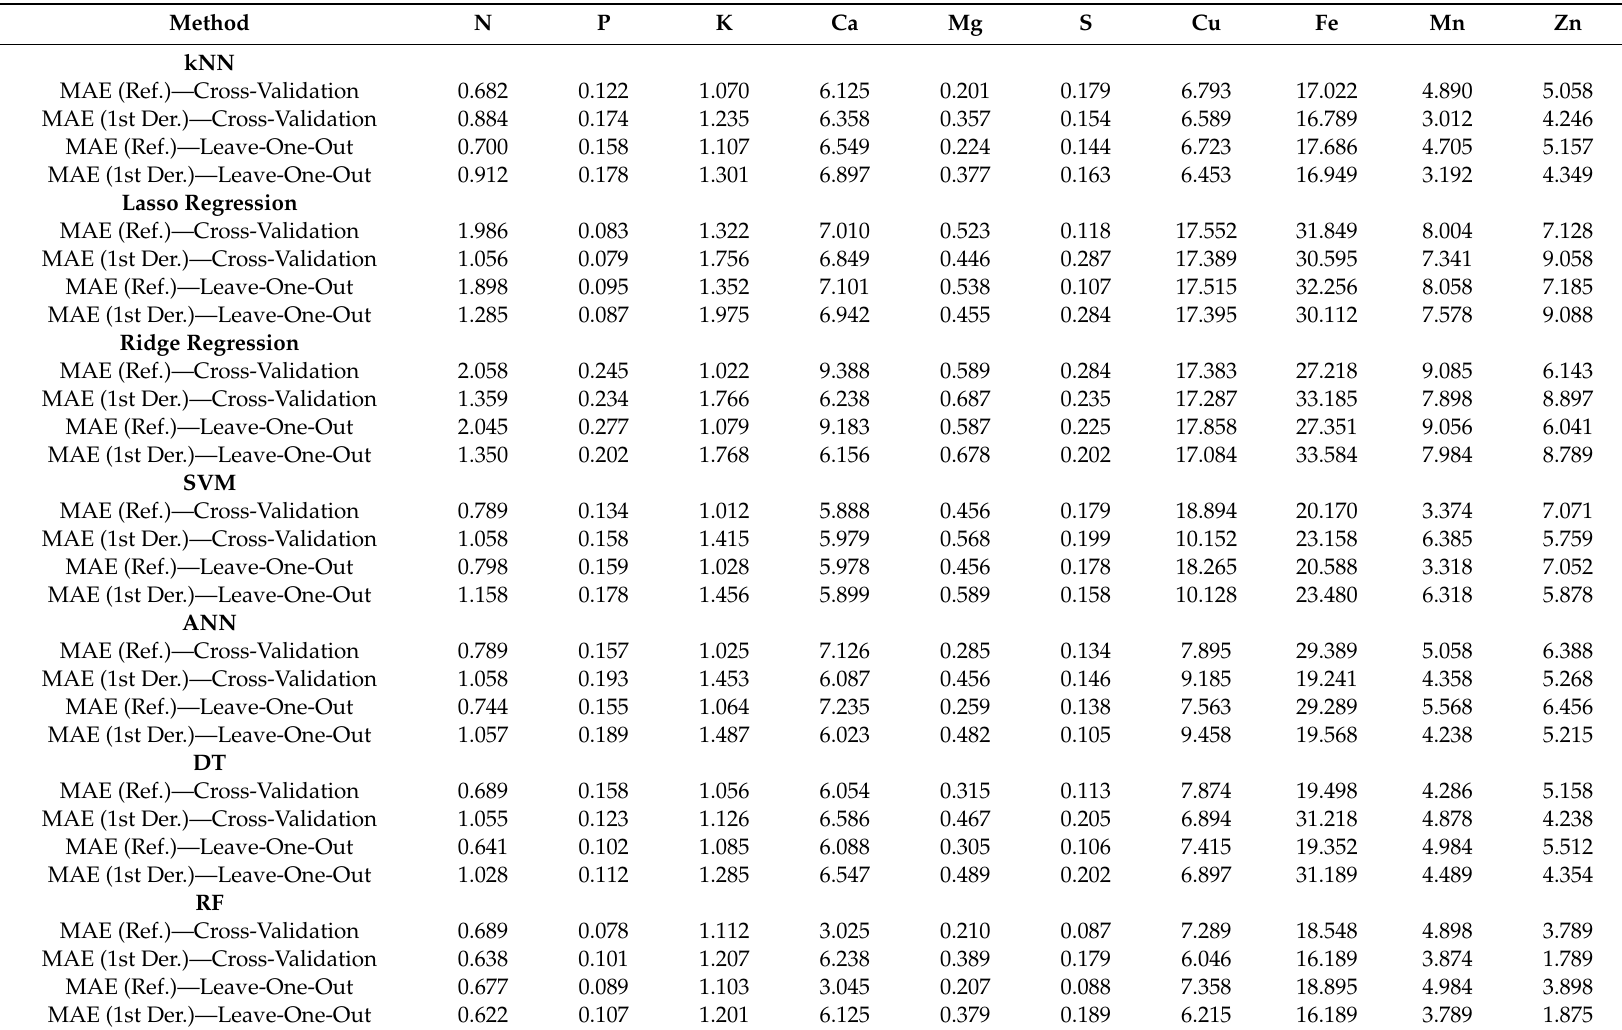
Table 2. MAE returned from both training methods: Cross-Validation and Leave-One-Out. Method